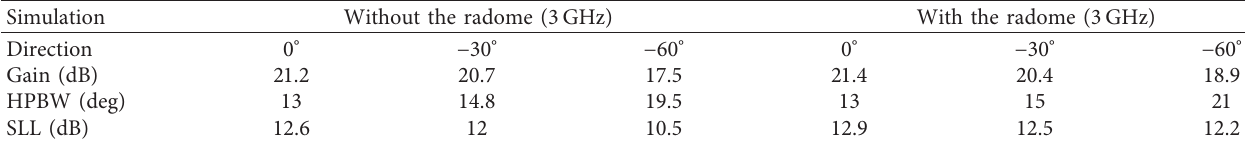
Table 3: Comparison of the specific values in Figure